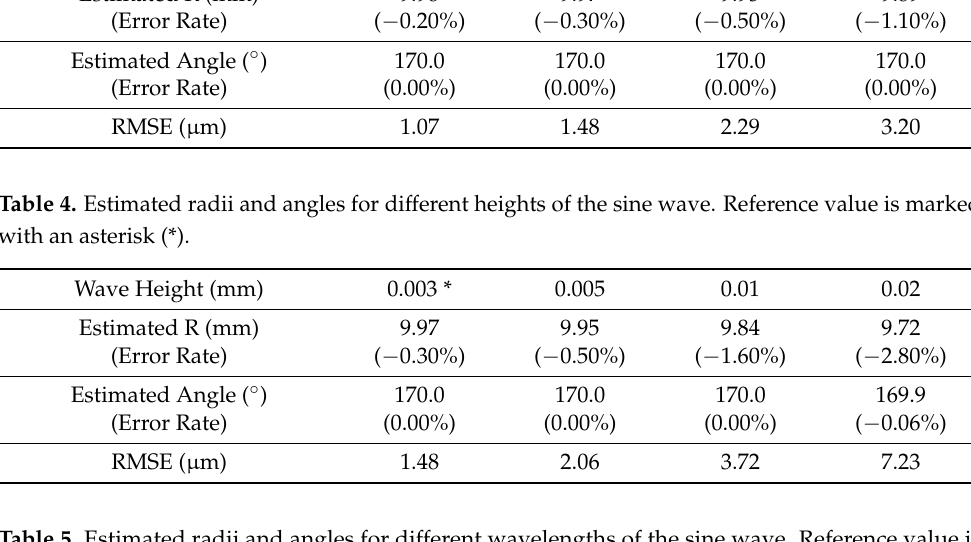
Table 5. Estimated radii and angles for different wavelengths of the sine wave. Reference value is marked with an asterisk